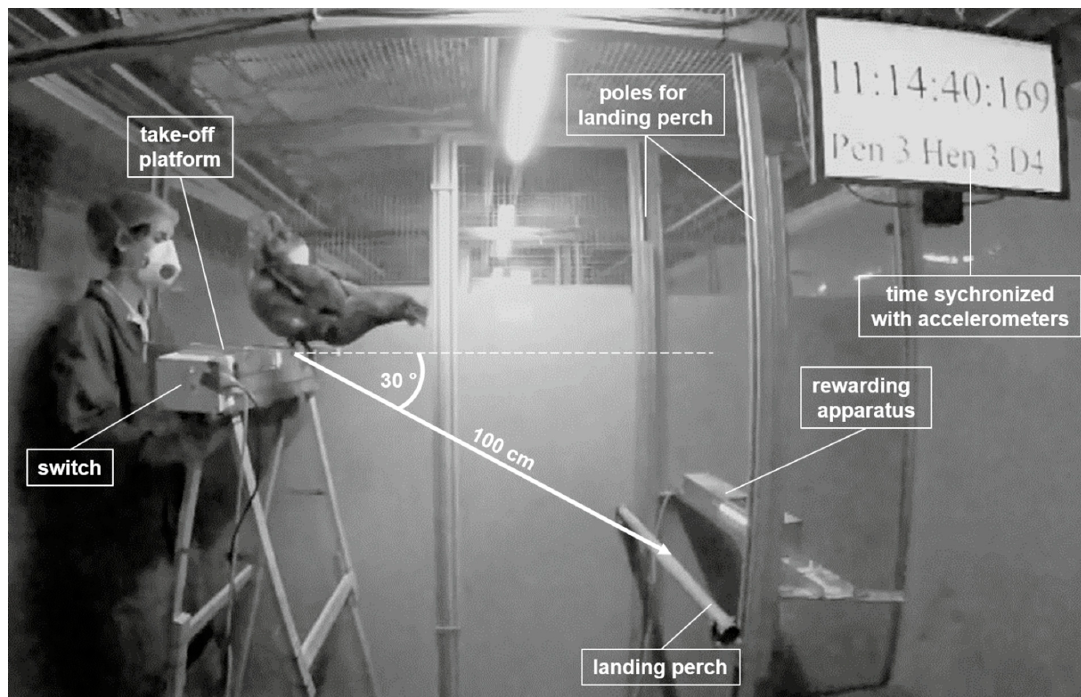
Figure 2. Testing apparatus in the test pen. Landing perch and rewarding apparatus are installed on both sides of the vertical poles. In this example, the take-off platform is placed with 100 cm diagonal distance to the landing perch with a 30° angle. The switch to open the flap of the rewarding apparatus is mounted on the take-off platform. The experimenter has her hands placed underneath the take-off platform with a neutral body posture.